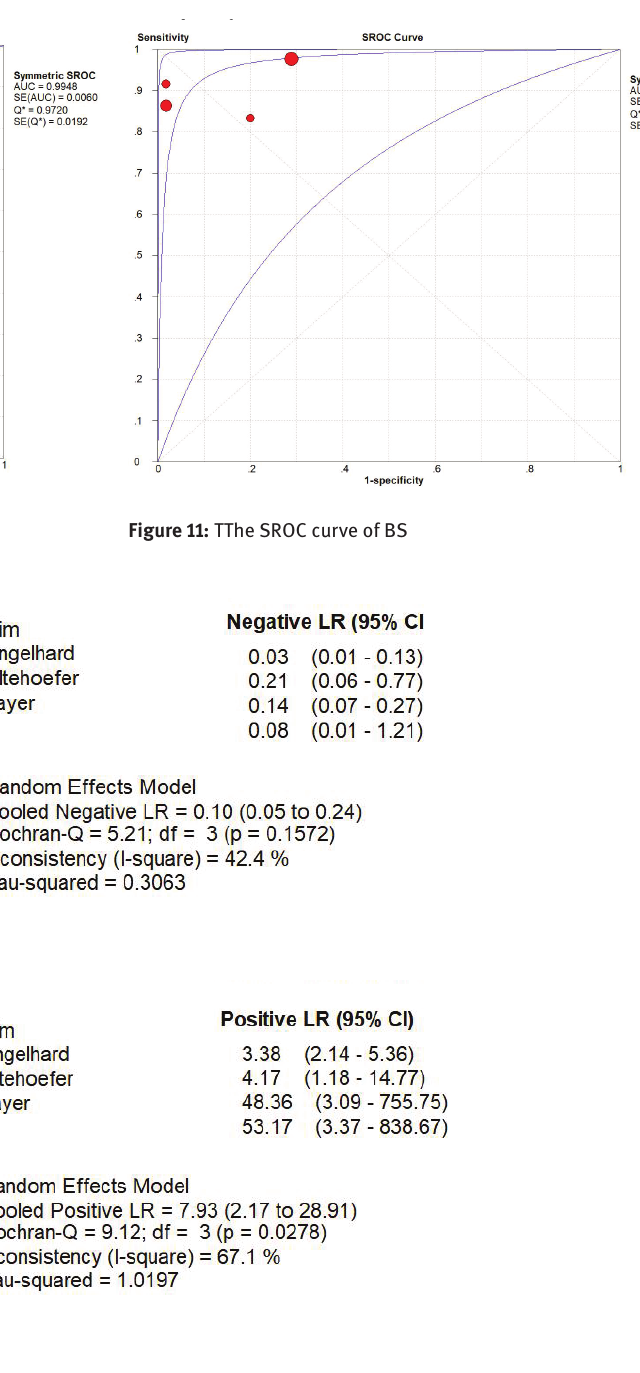
Figure 10: The plot for the sensitivity of